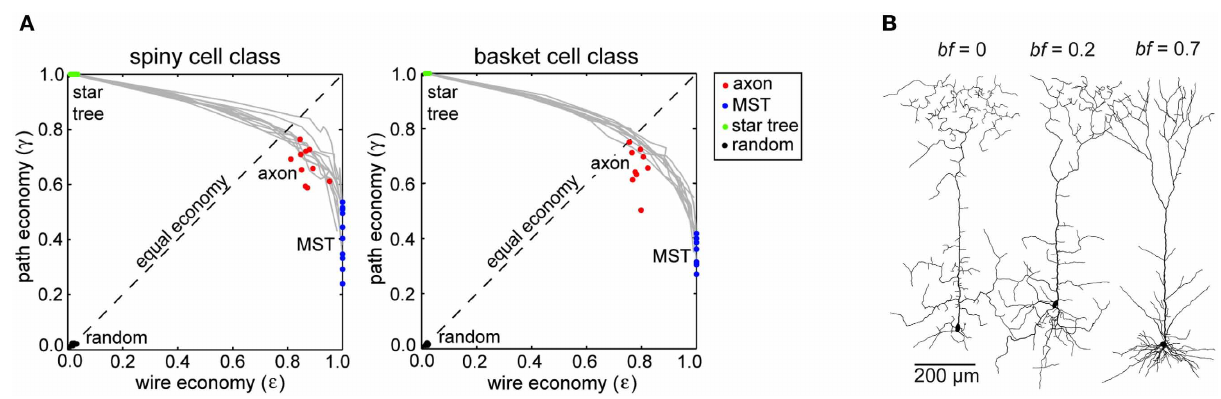
than random arbors (Reprinted from Budd et al., 2010). (B) Examples of spiny pyramidal cell dendritic arbors generated using different trade-off balancing factor ( bf ) values show that the most realistic looking arbor was obtained for bf = 0 . 7 (Reprinted from Cuntz et al., 2010). Note bf parameter is equivalent to β parameter in Figure 2